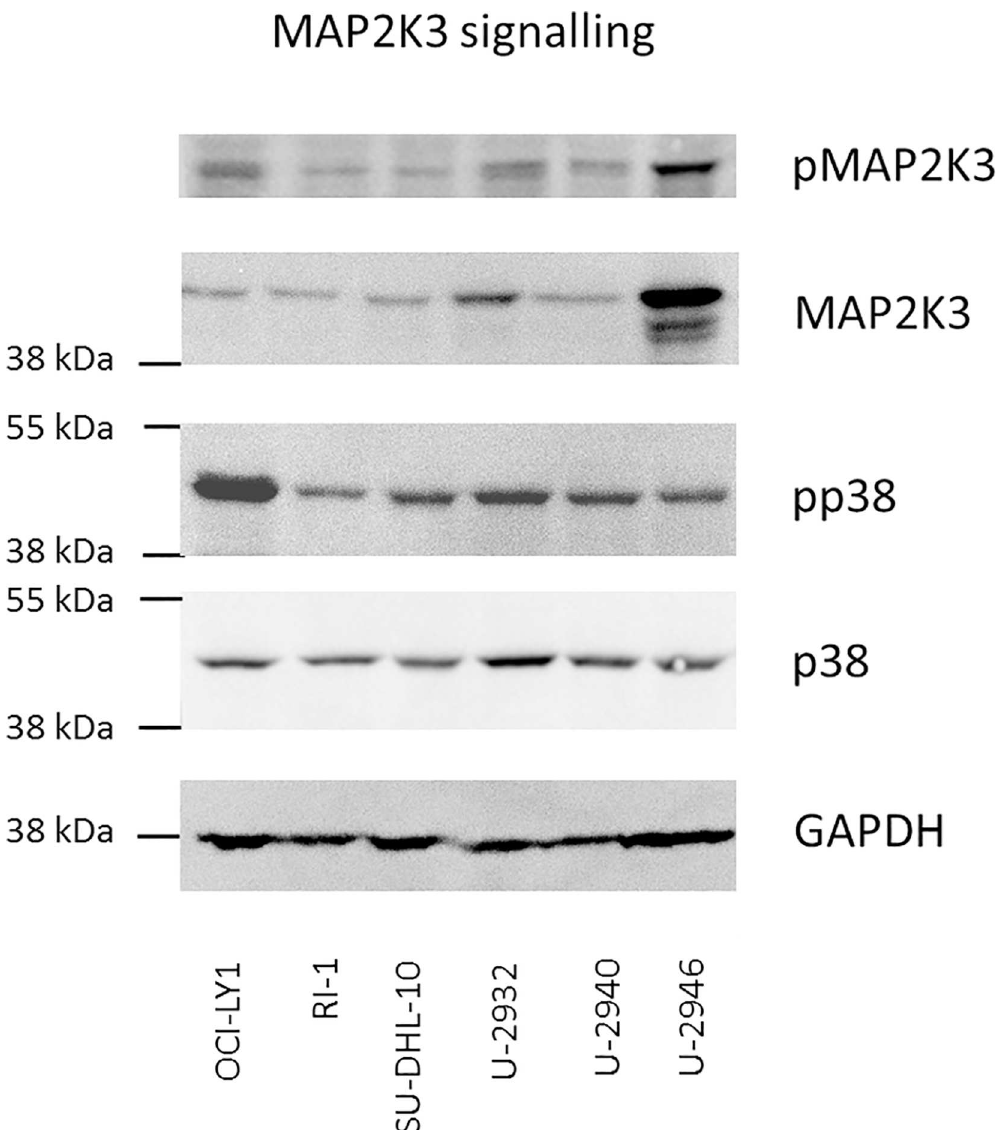
Fig 4. Phosphorylation of the MAP2K3/p38 pathway. Expression and phosphorylation of MAP2K3 and p38 in U- 2946 and five other DLBCL cell lines was determined by Western blot analysis.Note that overexpression of MAP2K3 was not accompanied by high phosphorylation of the MAP2K3 target in cell line